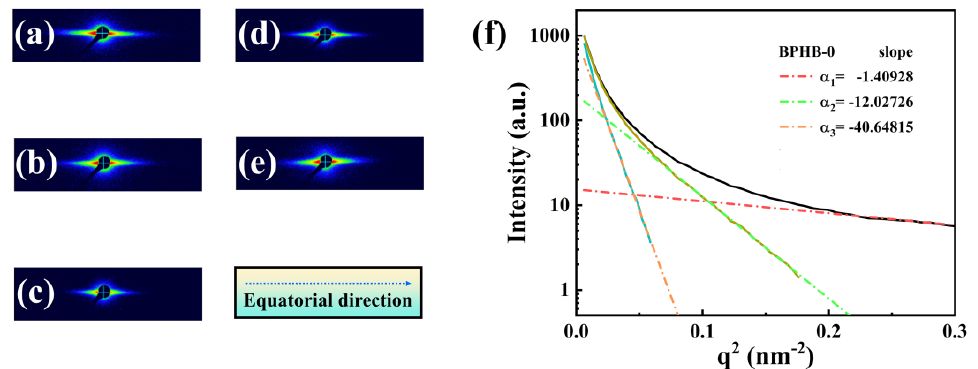
Figure 4. ( a – e ) 2D SAXS patterns for BPHB fibers with p – PDA /HAB/BIA molar ratios of 7/0/3, 6/1/3, 4/3/3, 2/5/3, and 0/7/3, respectively. ( f ) Guinier plot of the BPHB – 0 fiber along the equator direction via Guinier functions and the Fankuchen successive tangent method.